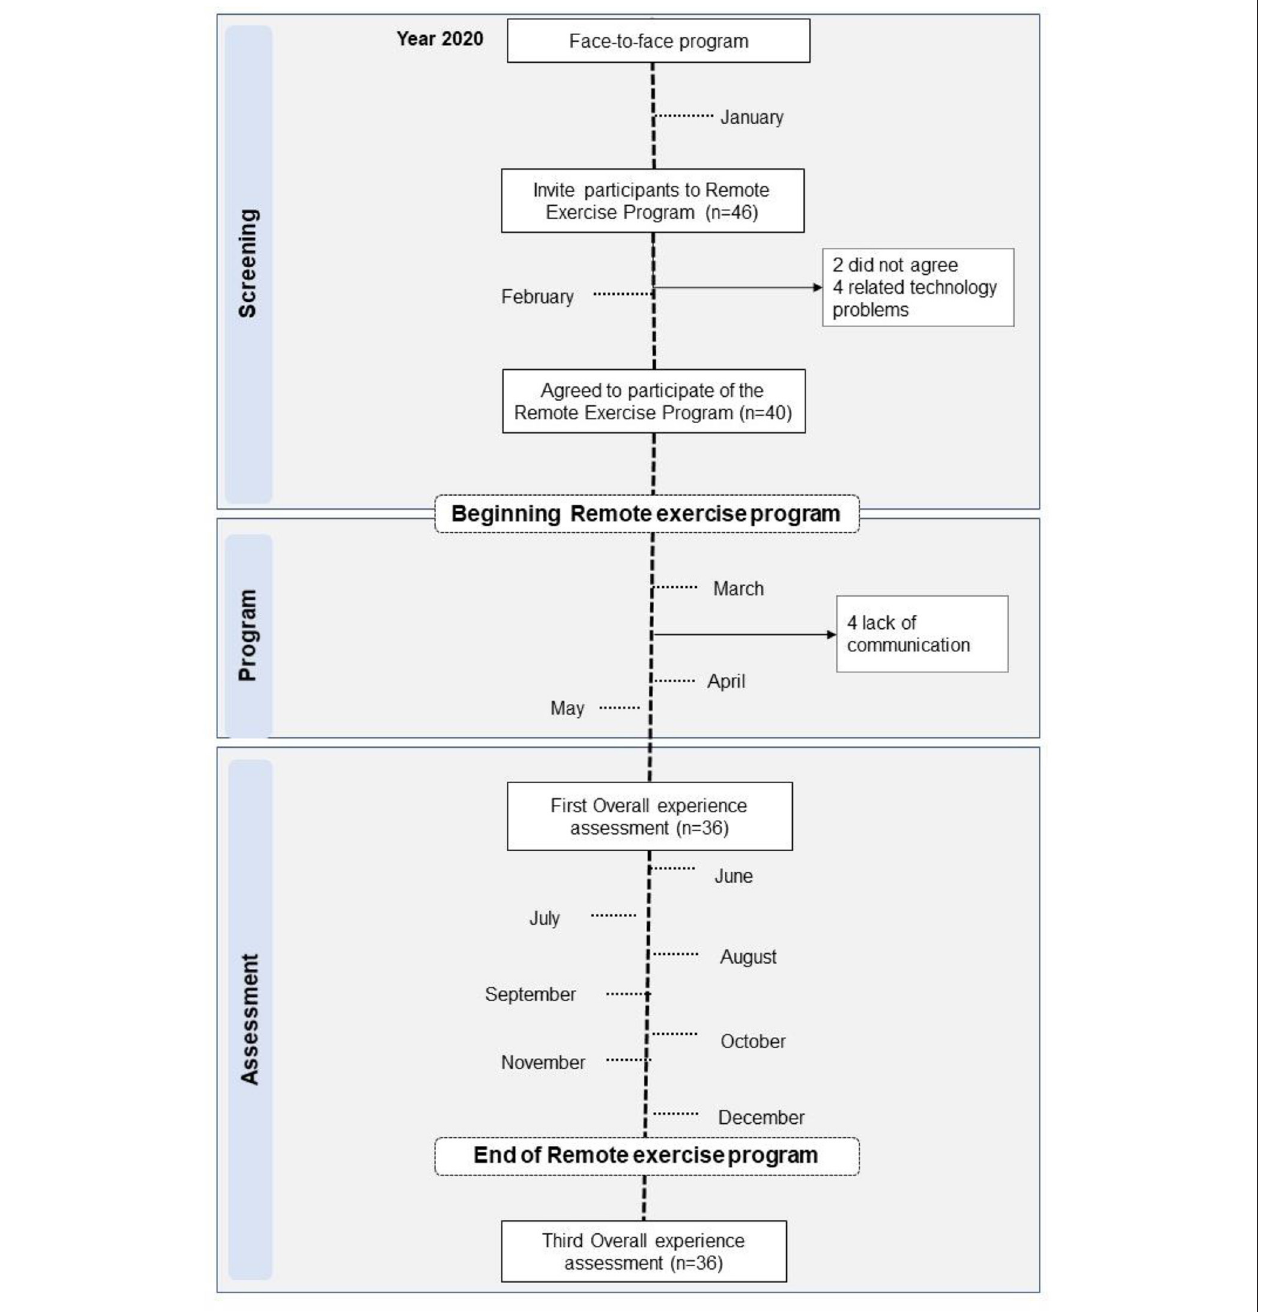
FIGURE 2 | Flowchart of the